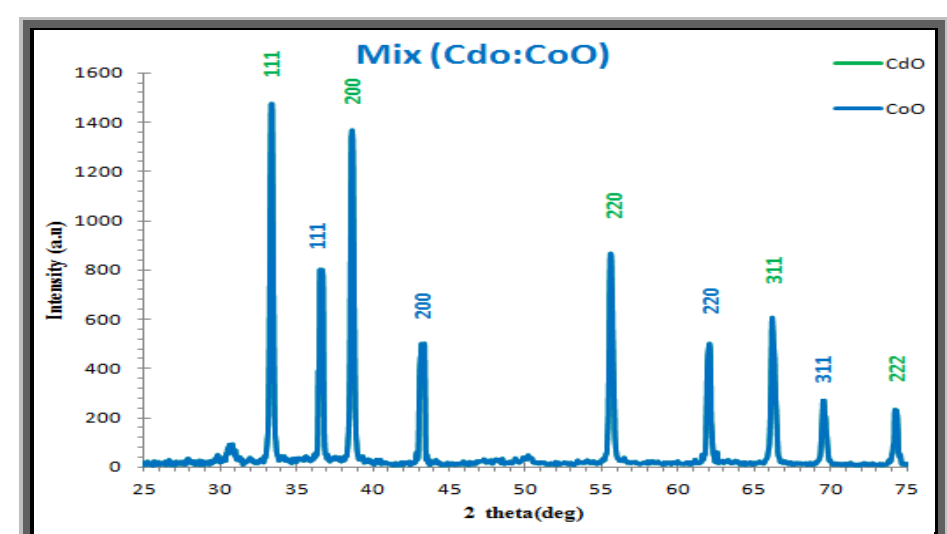
Fig. 5: Patterns of XRD for mix powder